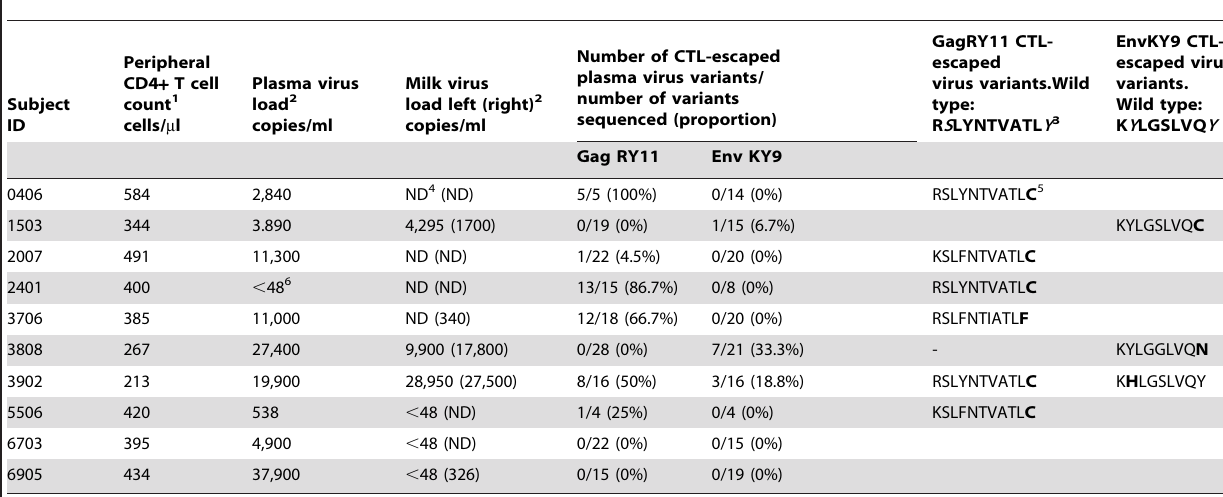
Table 2. The CD4 count, virus load, and proportion of plasma virus variants with CTL-escape at the HLA A*3002-restricted immunodominant GagRY11 and subdominant EnvKY9 epitopes in HIV-infected, A*3002 + , lactating Malawian